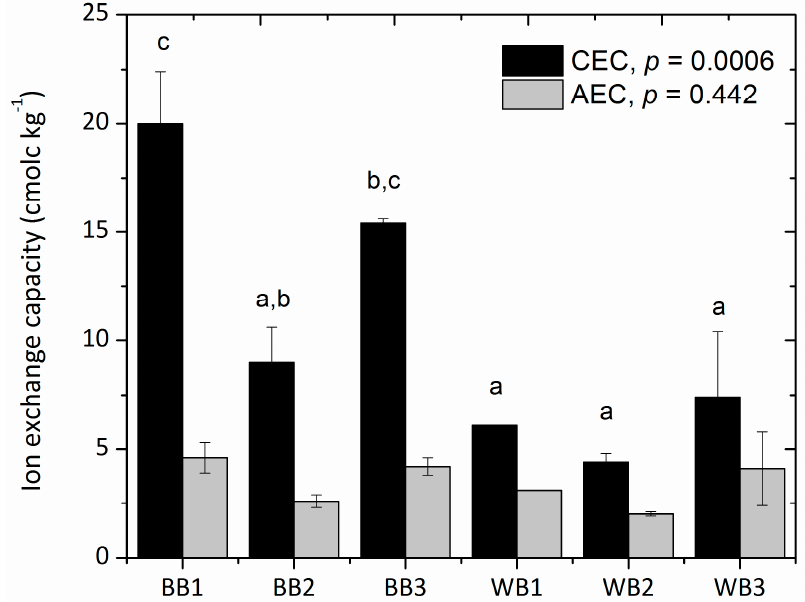
Figure 4. Cation exchange capacity (CEC) and anion exchange capacity (AEC) of six biochar samples. Notice that BB and WB indicate bamboo and pinewood biochar, respectively. Different letters mean statistical significant differences using Tukey’s test ( p < 0.05).